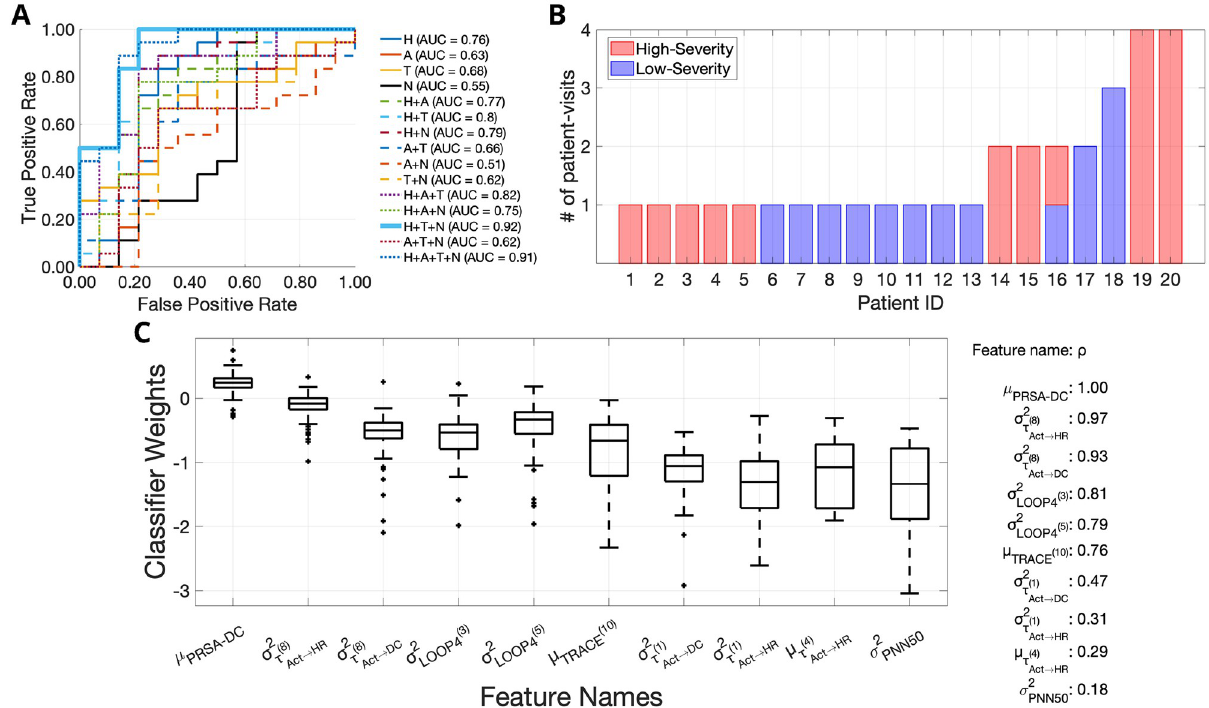
Fig 4. The feature combination of heart rate variability (HRV) metrics, multiscale transfer entropy, and multiscale network representation achieves the highest area under the receiver operating curve (AUC), equal to 0.92. (A) The ROCs for the 15 different Rett severity classifiers are provided. Each classifier uses a different subset-combination of the four feature sets, namely: (1) HRV metrics (H), (2) Actigraphy metrics (A), (3) Multiscale transfer entropy features (T), (4) Multiscale network representation features (N). The combination of H+T+N performed the best with a leave one-patient out cross-validation pooled-AUC equal to 0.92. The individual ROCs corresponding to the individual classifiers are shown using a combination of line styles and colors. The figure legend shows the pooled-AUC values for each feature combination. (B) A depiction of the number of patient-visits for each of the 20 patients showing the low-severity and high-severity patient-visits in different colors. (C) The top 10 most popular features used by the best classifier (H+T+N) for Rett severity classification are shown here, along with the corresponding feature coefficients. The mean ) is the most popular feature with a feature popularity score of 1 followed by s 2 and s 2 with feature popularity deceleration capacity ( μ PRSA − DC t ð 8 Þ Act ! HR t ð 8 Þ Act ! DC scores 0.97 and 0.93, respectively. In the top-10 most popular features for the H+T+N feature combination, two features were HRV-metrics ( μ PRSA − DC and s 2 ), three features were MSNR-features ( s 2 , s 2 and μ TRACE (10) ) and the rest five were PNN 50 LOOP 4 ð 3 Þ LOOP 4 ð 5 Þ